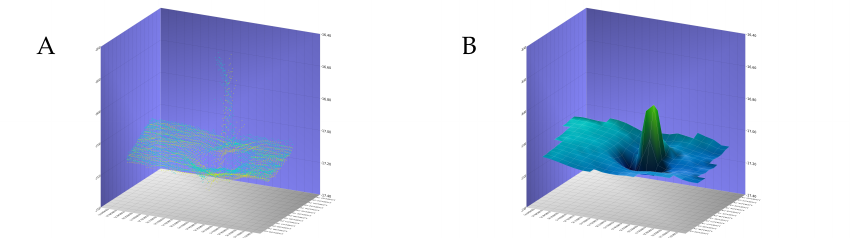
Figure 10. Section of the point cloud data visualized in Qimera after the navigation correction using Huber loss as individual sounding color-coded by file ( A ) and surface ( B ). The height is exaggerated to make the feature more prominent. Instead of two halves of one object, the algorithm directly matches the halves to be exactly at the same position. This bias can be observed multiple times in the survey